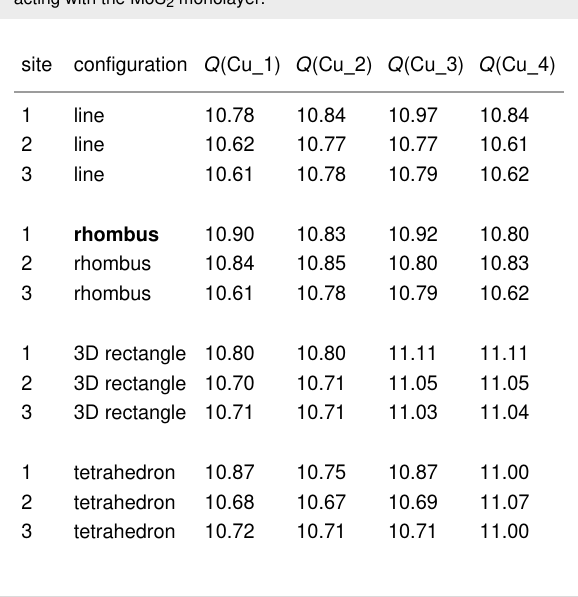
Table 6: Computed Bader charge ( Q ) at each Cu atom for different adsorption configurations with four Cu atoms. For the 3D rectangle configurations, Cu_1 and Cu_2 are interacting with the monolayer and Cu_3 and Cu_4 are adsorbed atop of Cu_1 and Cu_2. For the tetrahe- dron, Cu_4 is at the apex, while Cu_1, Cu_2 and Cu_3 are all inter- acting with the MoS 2